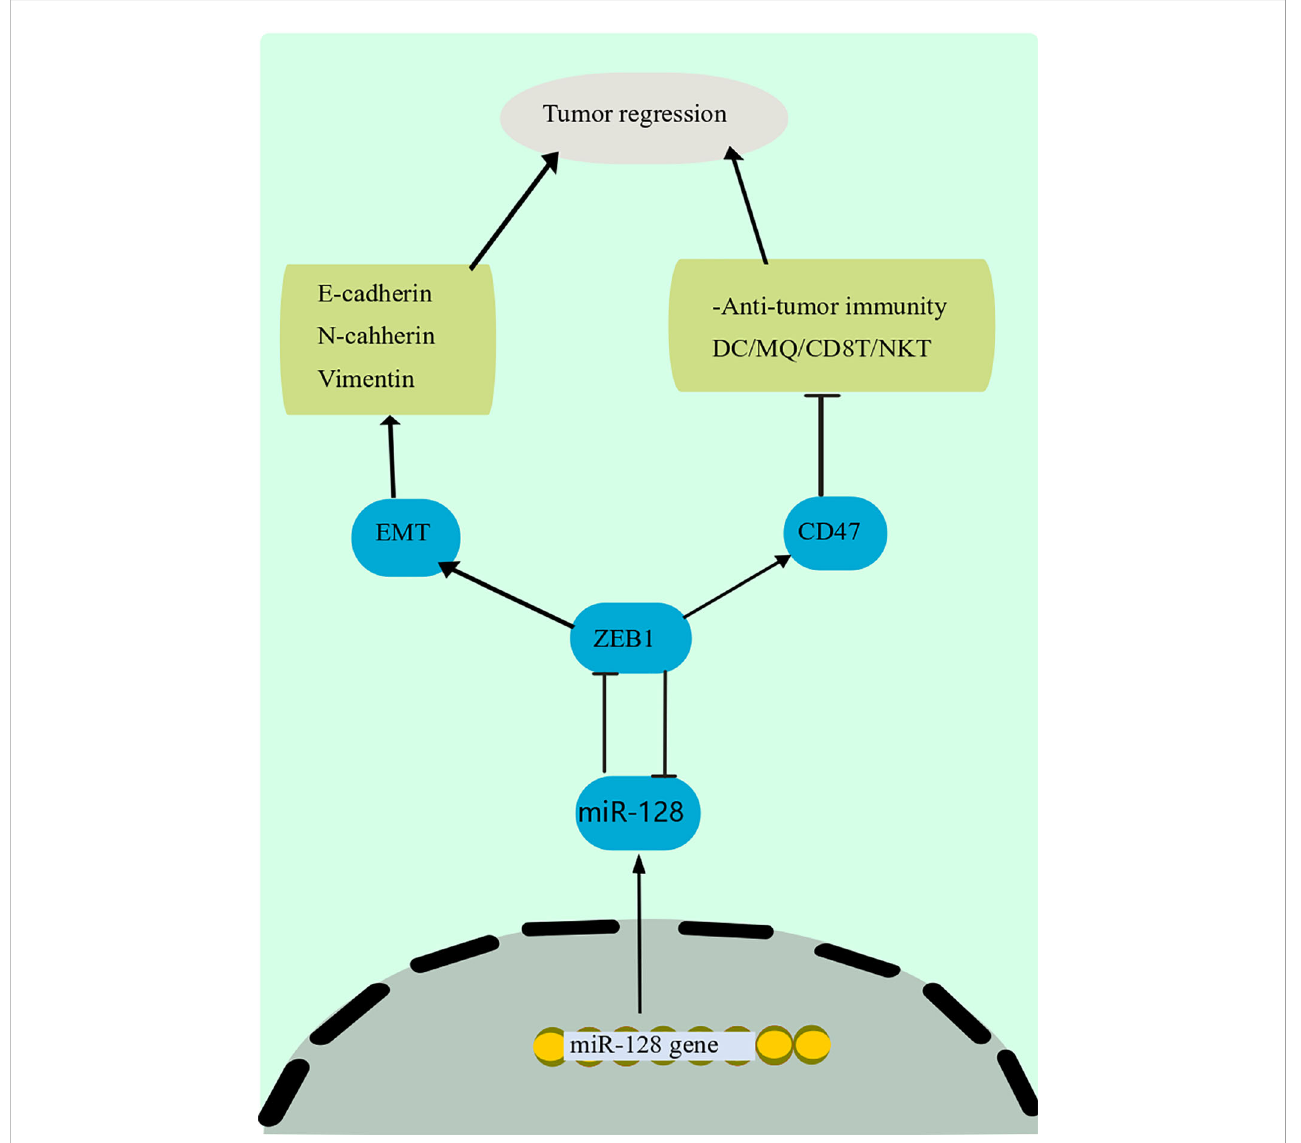
FIGURE 4 Anti-tumor immunity mechanism of miR-128. miR-128 modulates the invasion of anticancer immune cells in the immunological milieu, comprising DCs, CD8 + T cells, and NKT cells, via the ZEB1/CD47 axis and EMT, eventually suppressing PC development and dissemination. The downstream mechanism of miR-128 in the EMT of cancer cells has been found in a study by targeting genes such as ZEB1. Among these target genes, ZEB1 has been mentioned to regulate the EMT of cancer cells in cervical cancer and esophageal squamous cell carcinoma. DCs, Dendritic cells; miR-128, microRNA-128; NKT, natural killer T; ZEB1, Zinc Finger E-Box Binding Homeobox 1; EMT, epithelial-mesenchymal